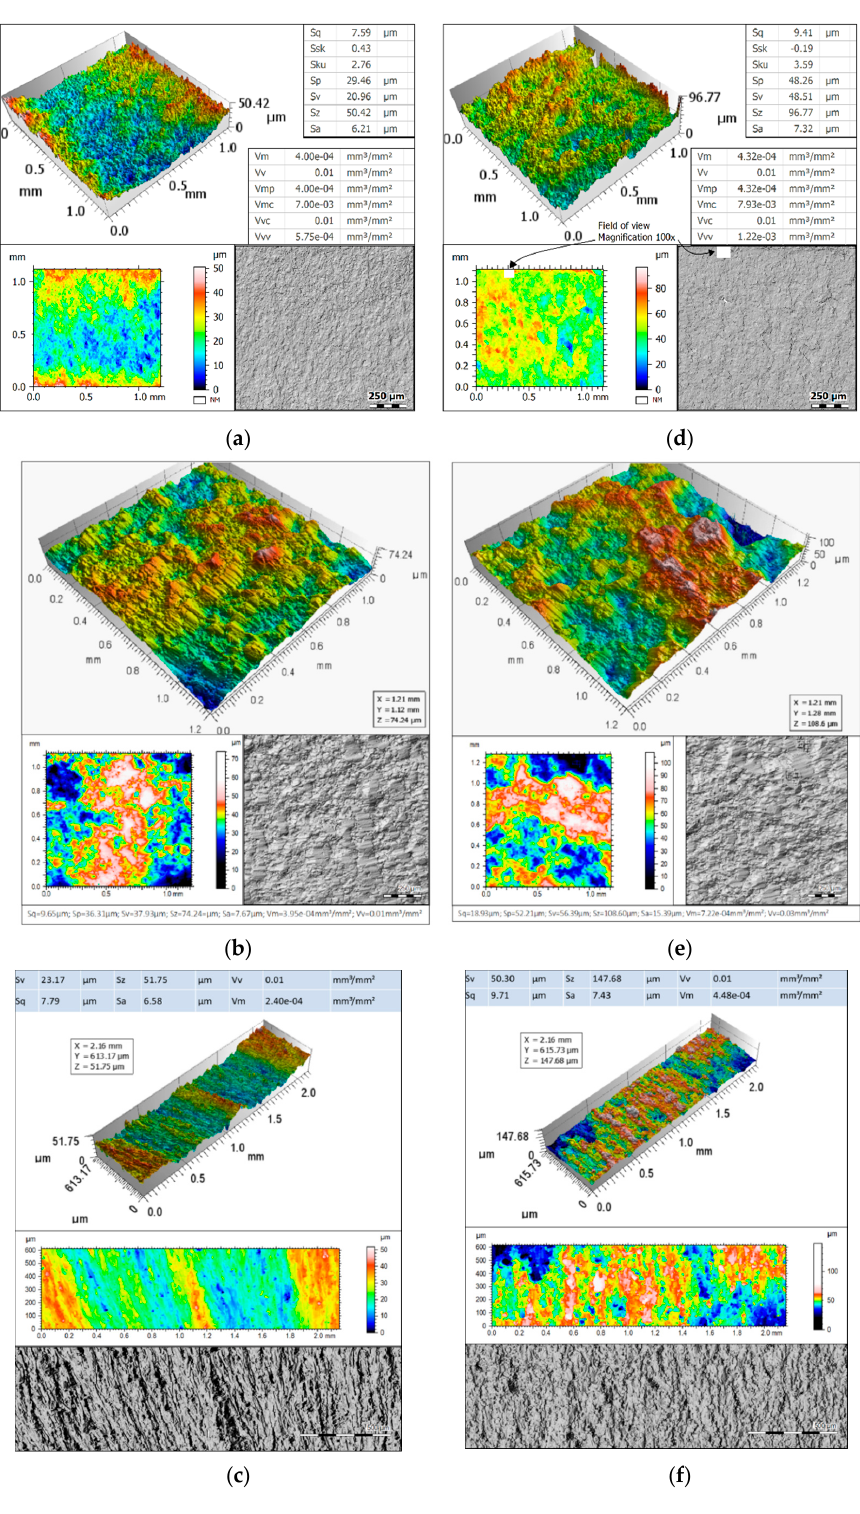
Figure 5. Propagation area view of the specimen made of: ( a ) 10HNAP steel; ( b ) S355J2 steel; and ( c ) AW-2017A-T4 aluminium alloy. Rupture area view of the specimen made of: ( d ) 10HNAP steel; ( e ) S355J2, steel; and ( f ) AW-2017A-T4 aluminium alloy.